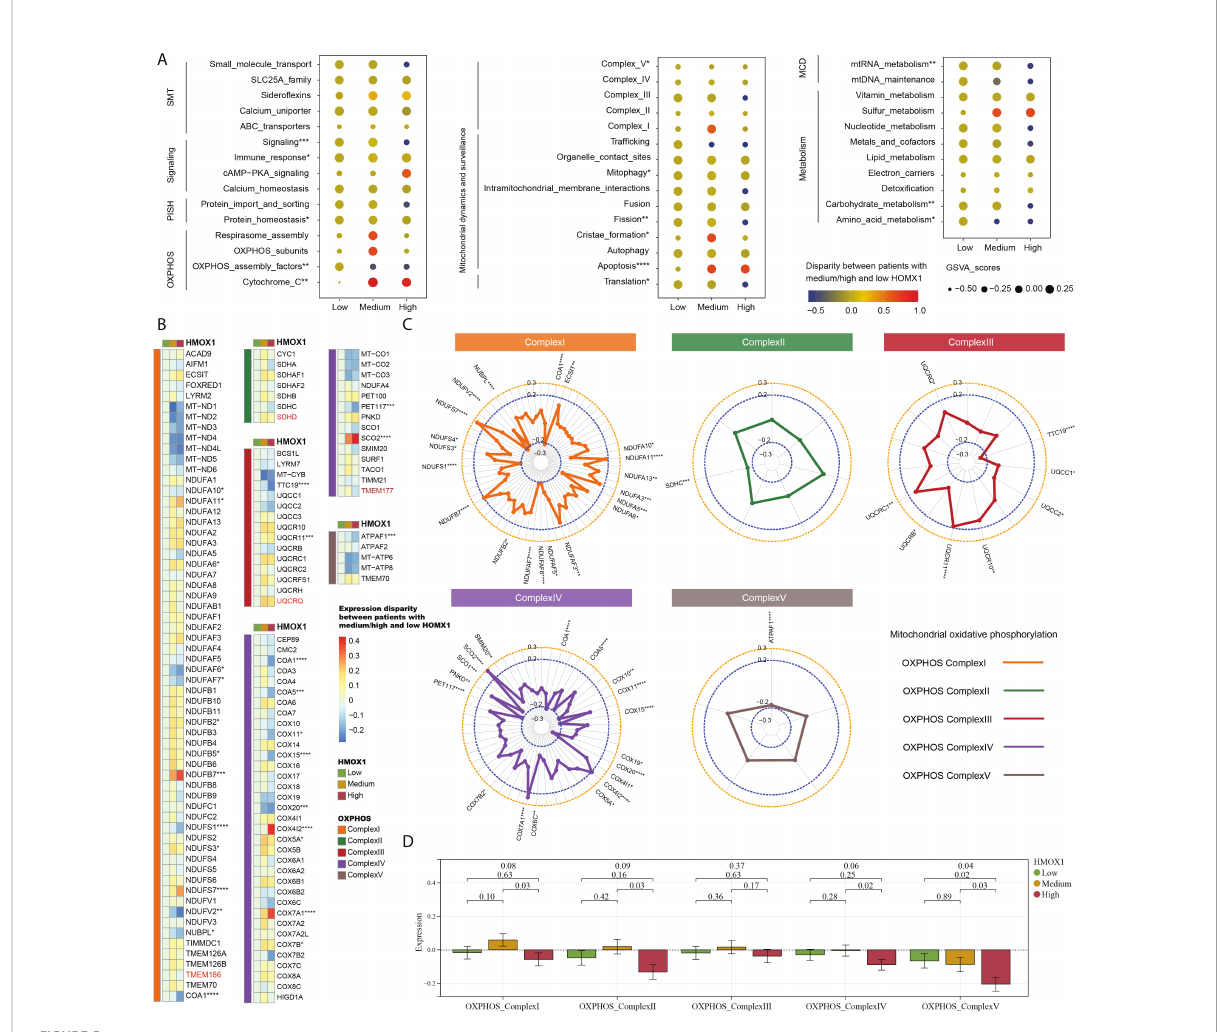
FIGURE 5 The effect of HMOX1 on mitochondrional activities in LUAD. (A) Differences in multiple mitochondrional pathways among the high, medium, and low HMOX1 groups. (B) Differences in feature genes of mitochondrial complexes among the high, medium, and low HMOX1 groups. (C) Correlation between HMOX1 and feature genes of mitochondrional complexes. (D) Differences in mitochondrional complex scoring between the high, medium, and low HMOX1 groups. SMT, small molecule transport; PISH, protein import, sorting and homeostasis; OXPHOS, oxidative phosphorylation; MCD, mitochondrial central dogma. *P < 0.05; **P < 0.01; ***P < 0.001; ****P <